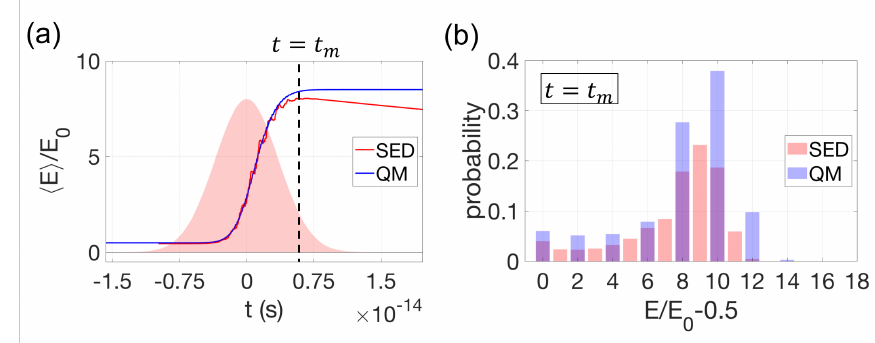
Figure 3. The QM and SED energy distributions after laser excitation. ( a ) The ensemble average of the SED oscillator energy (red line) is compared with the expectation value of the QM oscillator energy ( blue line ) during the course of laser excitation. The shaded area ( red ) represents the excitation laser pulse e − ( t / τ ) 2 . The pulse duration is τ = 5 × 10 − 15 (s), which is much smaller than the SED oscillator damping time τ d ≈ 3.2 × 10 − 13 (s). Therefore, damping has no significant effect on the oscillator’s dynamics during the excitation process. ( b ) Energy distributions of QM and SED oscillators are compared at t = t m when the SED energy reaches its maximum and the radiation damping starts to dominate. The QM energy distribution ( blue bar ) is discrete and occupies only even energy levels E 2 k = E 0 ( 2 k + 1/2 ) , where E 0 = ¯ h ω 0 . The SED energy distribution ( red bar ) is continuous but has a similar width and average value as the QM distribution. This indicates that the excitation process is identical for QM and SED